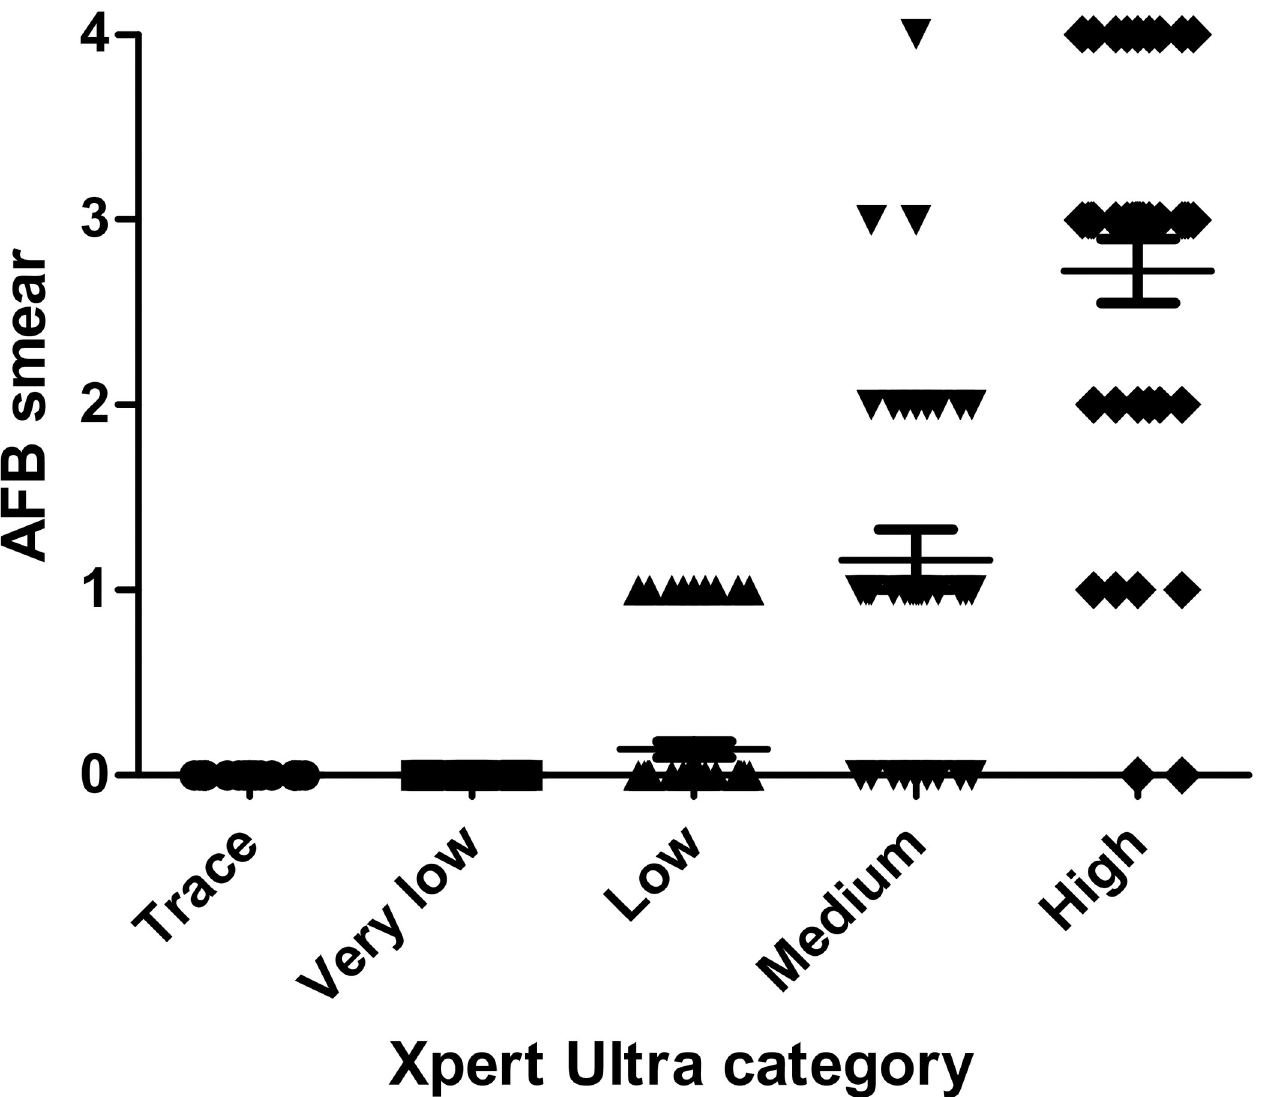
Fig 1. Correlation between Xpert Ultra categories and AFB smear microscopy score. P < 0,0001.